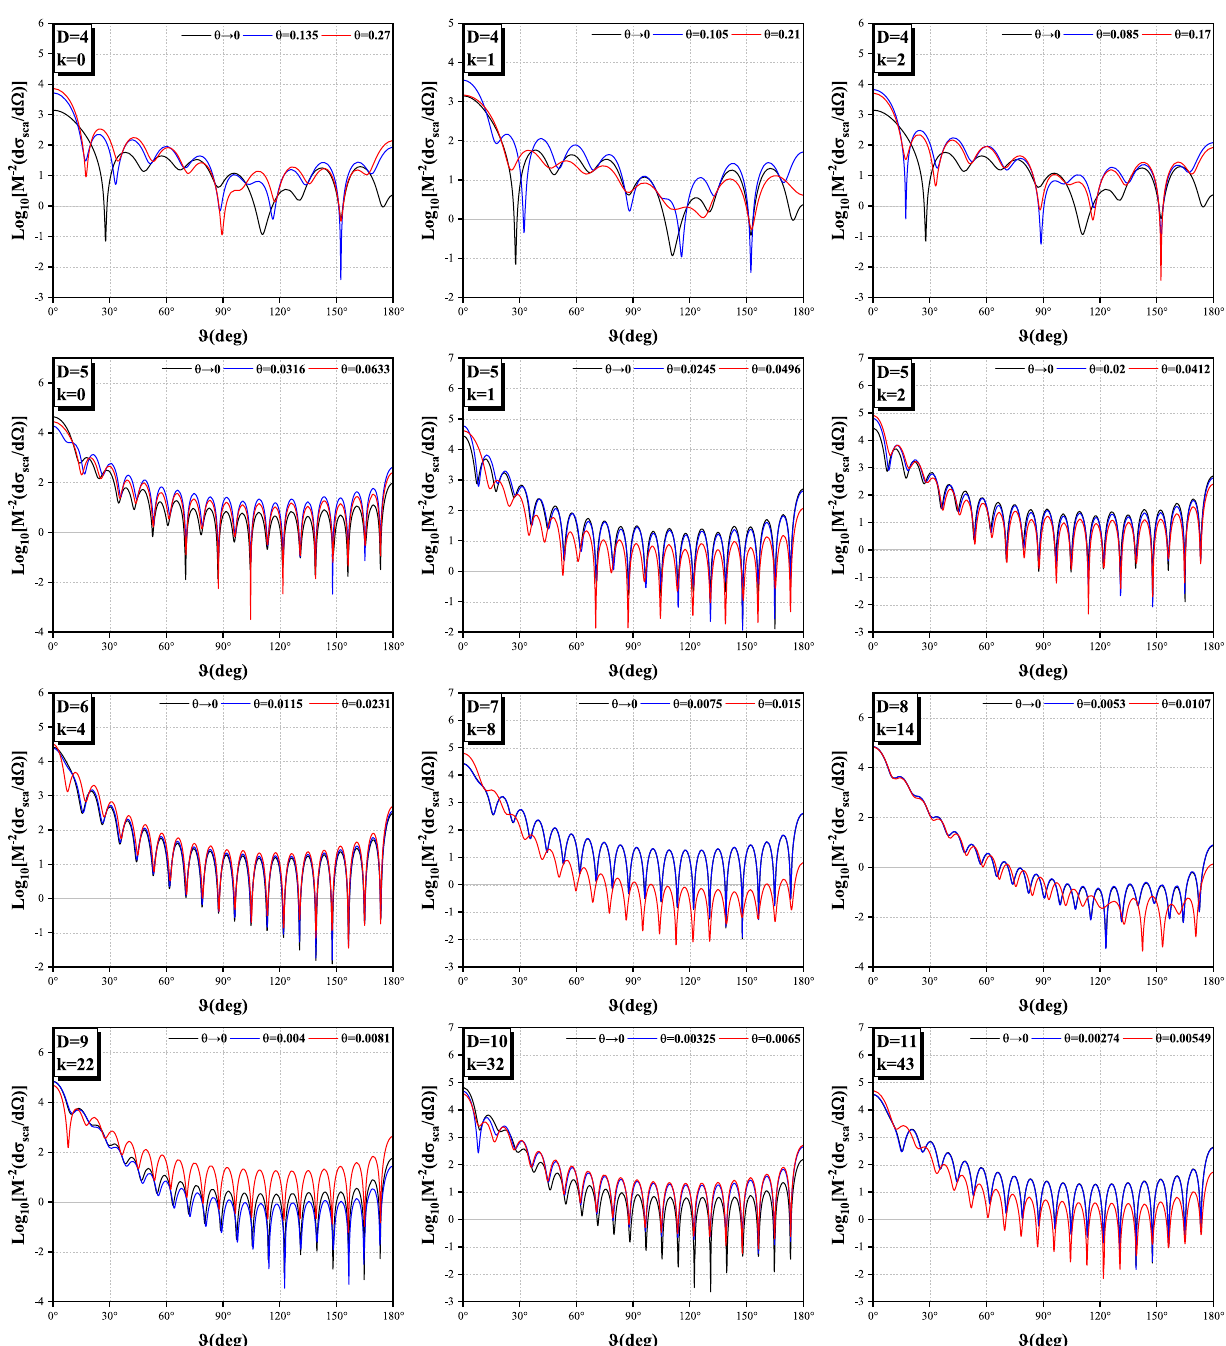
Fig. 4 The logarithm values of the differential scattering cross sections of high dimensional non-commutative black holes with different values of k and D are plotted in the range of ϑ = 0 ◦ to ϑ = 180 ◦ , with ω M =1